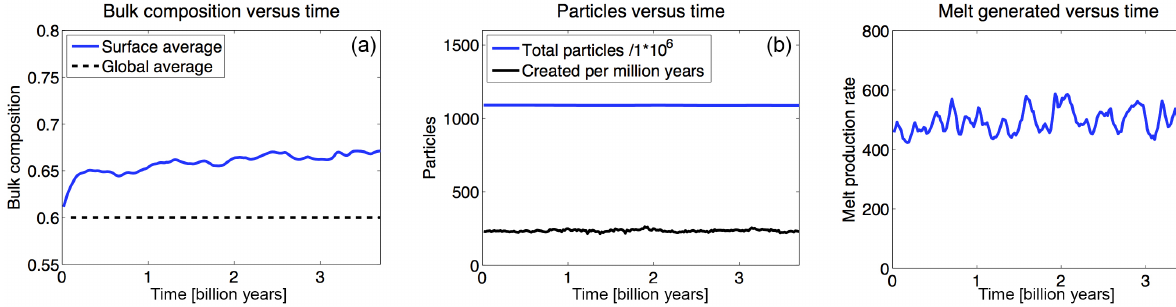
Figure 5. Time diagnostics of (a) bulk composition (left diagram); (b) particle evolution (middle diagram); and (c) melt generation (right diagram). (a) The global average bulk composition (dashed black line) stays at the initial value of 0.6, showing conservation of composition. The surface average (solid blue line) was measured as the average bulk composition of the particles that are in the top layer of elements. The surface average composition is always a bit higher than the global average since, on melting, basalt (composition = 1) is sent (i.e. migrates) to the surface. (b) The solid blue line indicates the total number of particles present in the domain over time. Although particles are created and merge continuously, the total count stays around 1.2 billion. The black line indicates the particle production rate, which is about 200 per million years. Over the full calculation time of 3.6 billion years around 0.7 million particles are created, which is less then 1 in 1000 compared to the total amount. (c) Melt production rate (in km 3 year − 1 ) versus time. The melt production varies by about 10% on short timescale ( ∼ 50MY) but is constant over longer timescales and never lower than ∼ 80% of the average value. The melt production as shown here included also the melt that was transported back to the same radial layer.